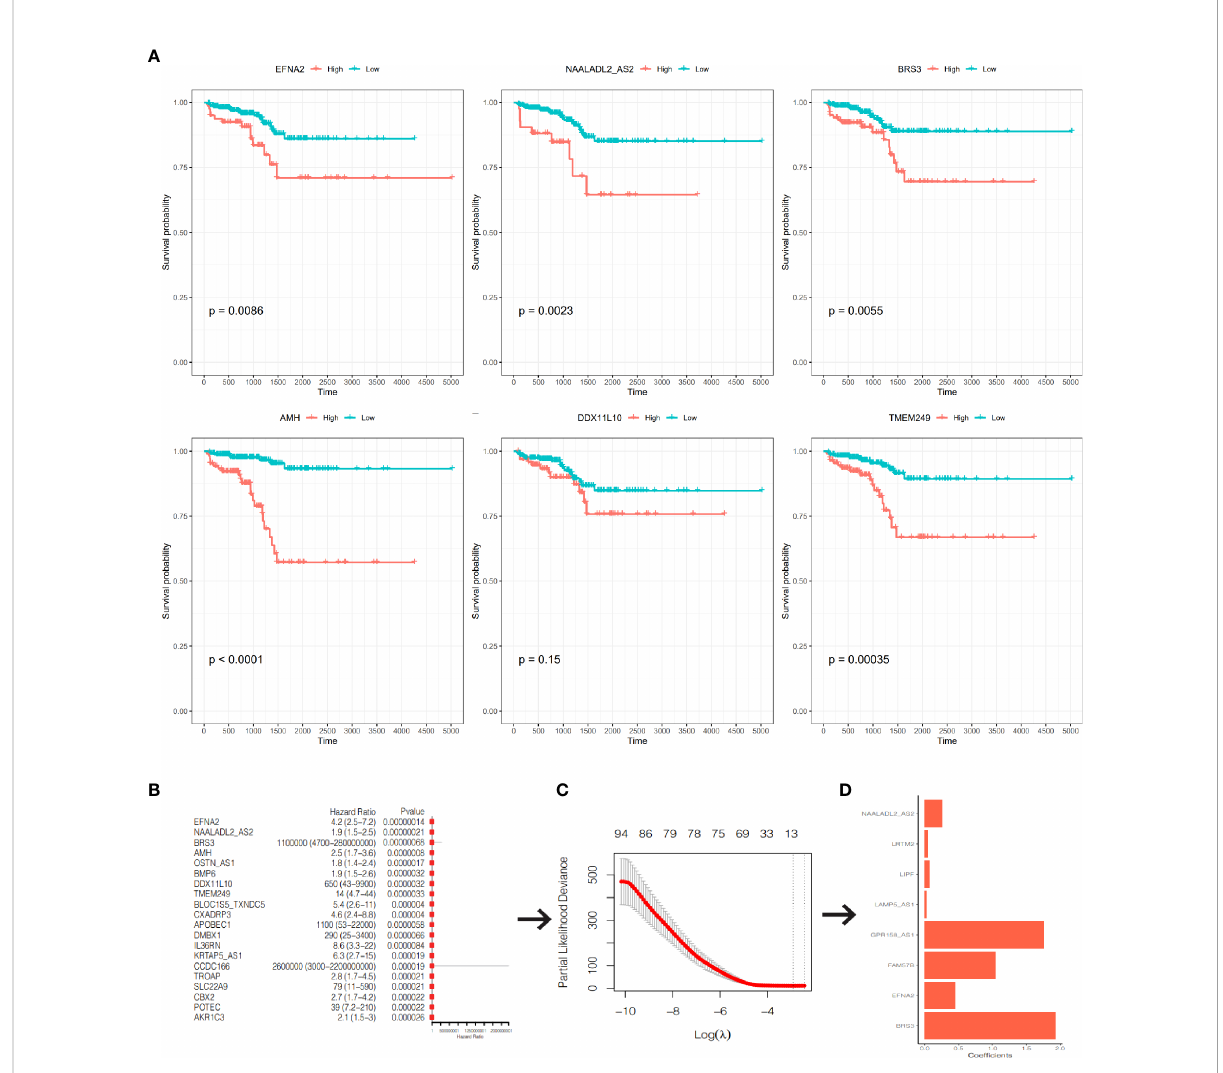
FIGURE 7 Construction of a prognostic signature. (A) The K-M curves of RFS of the top 6 genes with the smallest P-value. (B) The forest plot of the top 20 genes with the smallest P-value. (C) Partial likelihood deviance was plotted against lag(lambda). The vertical botted lines indicate the lambda value with minimum error. (D) The coef fi cients of the 8 genes in the